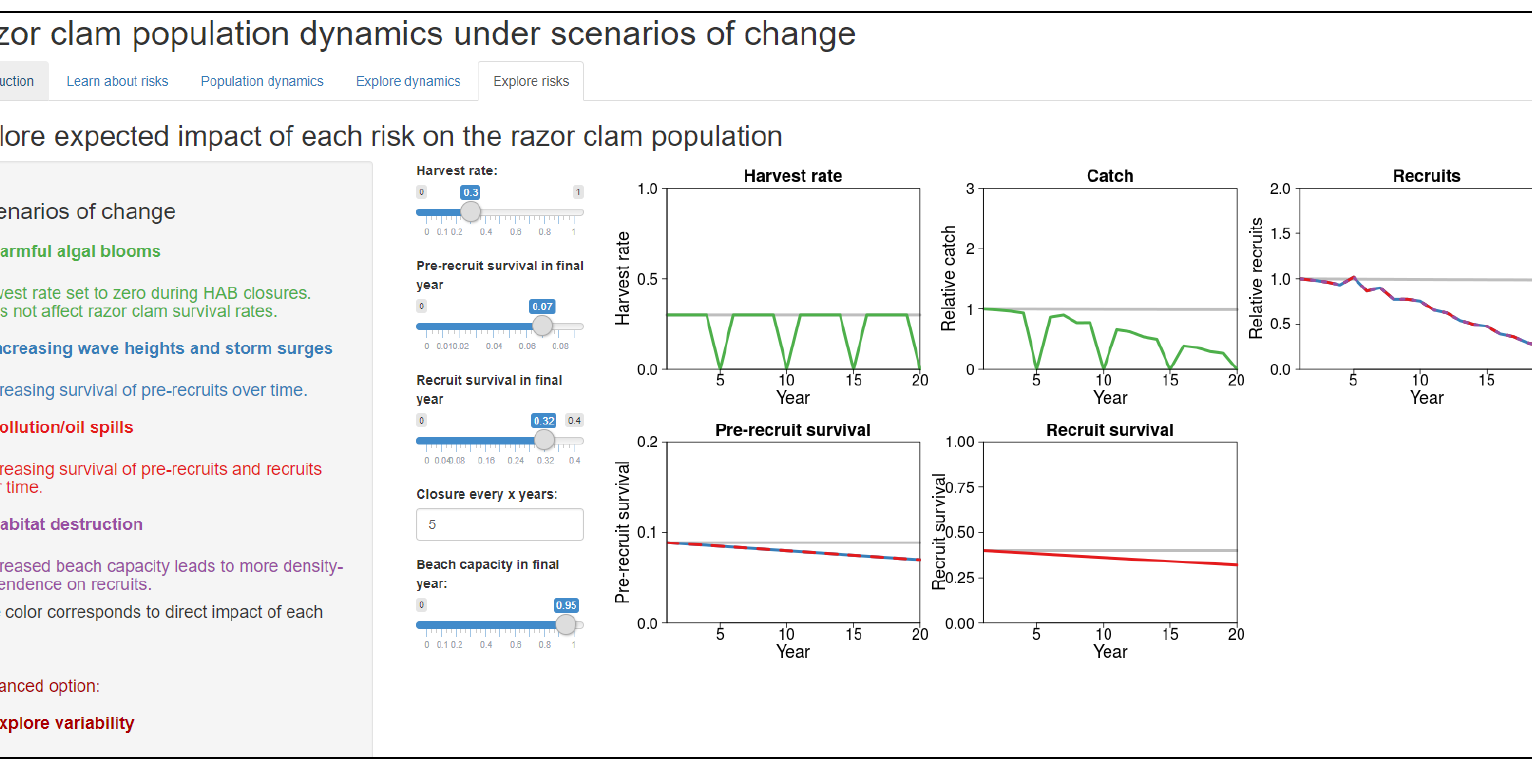
Figure A6.1. Screenshot of the shiny app (https://merrillrudd.shinyapps.io/razor_clam_pop/) “Explore risks” tab where the user can examine the expected impact of any combination of harmful algal blooms, increasing wave heights and storm surge, pollution and oil spills, and habitat destruction on harvest rate, catch, and recruits as implemented via harvest closures, changing survival rates, and beach